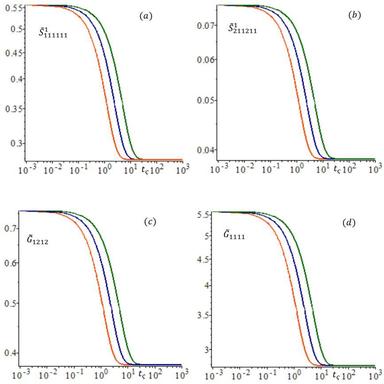
Dimensionless constitutive tensor components vs. the dimensionless time tς by varying the dimensionless relaxation time as τ i ς = 1 (red), τ i ς = 2 (blue) and τ i ς = 4 (green), with i = 1, 2 and for rρ = rE = 10, ν˜1 = ν˜2 = 0.2, η = 1 and γ = 1. (a) S˜1 111111; (b) S˜1 211211; (c) G˜1212 and (d) G˜1111. (For interpretation of the references to colour in this figure legend, the reader is referred to the web version of this article.)